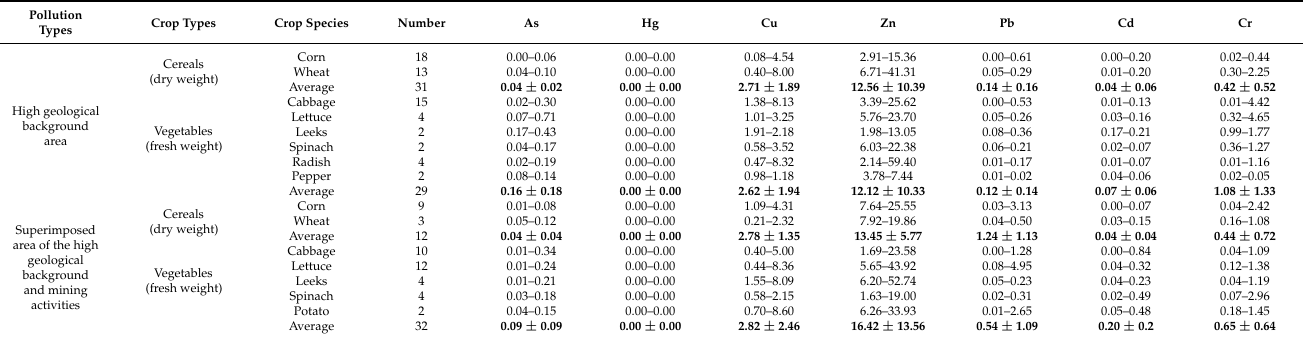
Table 5. Concentration of PTEs in crops edible parts (mg · kg − 1